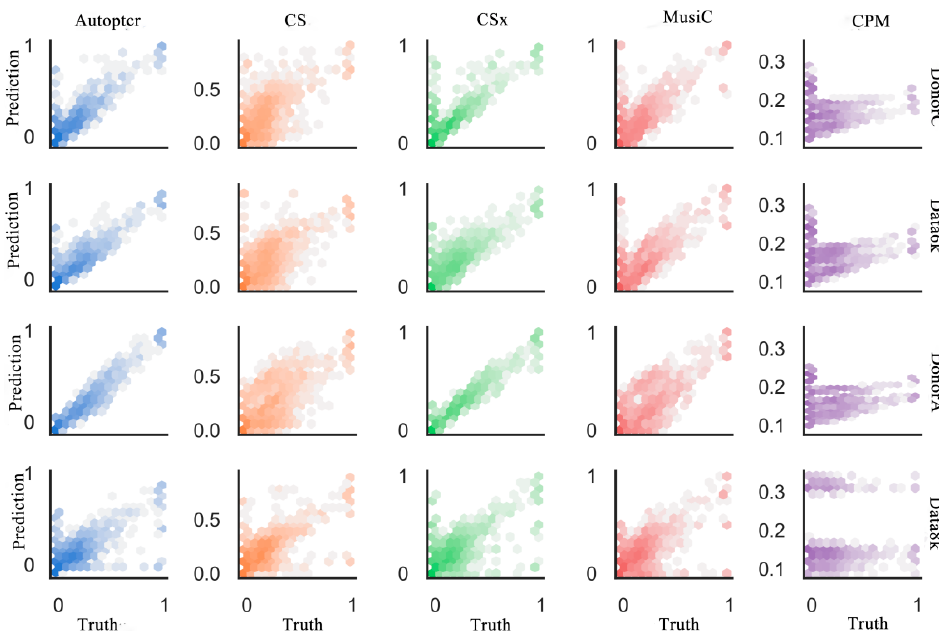
Figure 5. Comparison of actual and predicted values of Autoptcr, CS, CSx, MusiC and CPM. The predicted value of the CPM method is always lower than the true value in the picture. On the data8k dataset, all methods do not perform very well; that is, this poor performance is not only seen in the Autoptcr